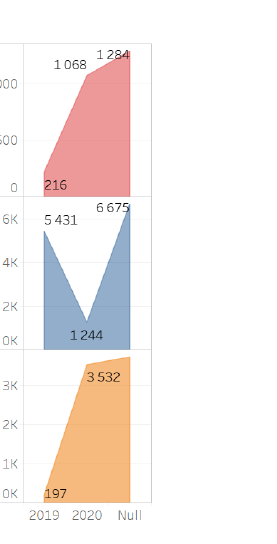
Figure 9. Dynamics of messages with various sentiment types.